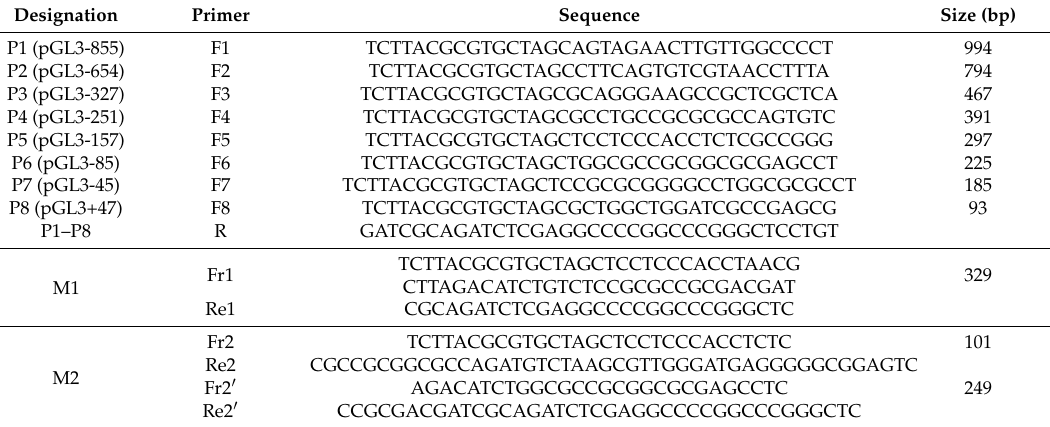
Table 1. Sequences of primers used for DNA cloning, nucleotides mutation, ChIP assay, and real-time